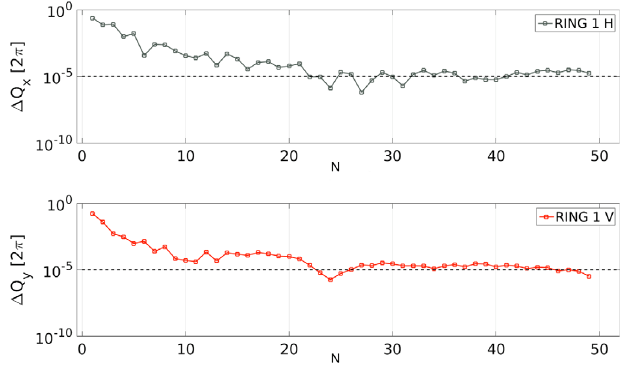
FIG. 18. Convergence of the tune measurements at the PSB ring 1 for the horizontal (top) and vertical (bottom)